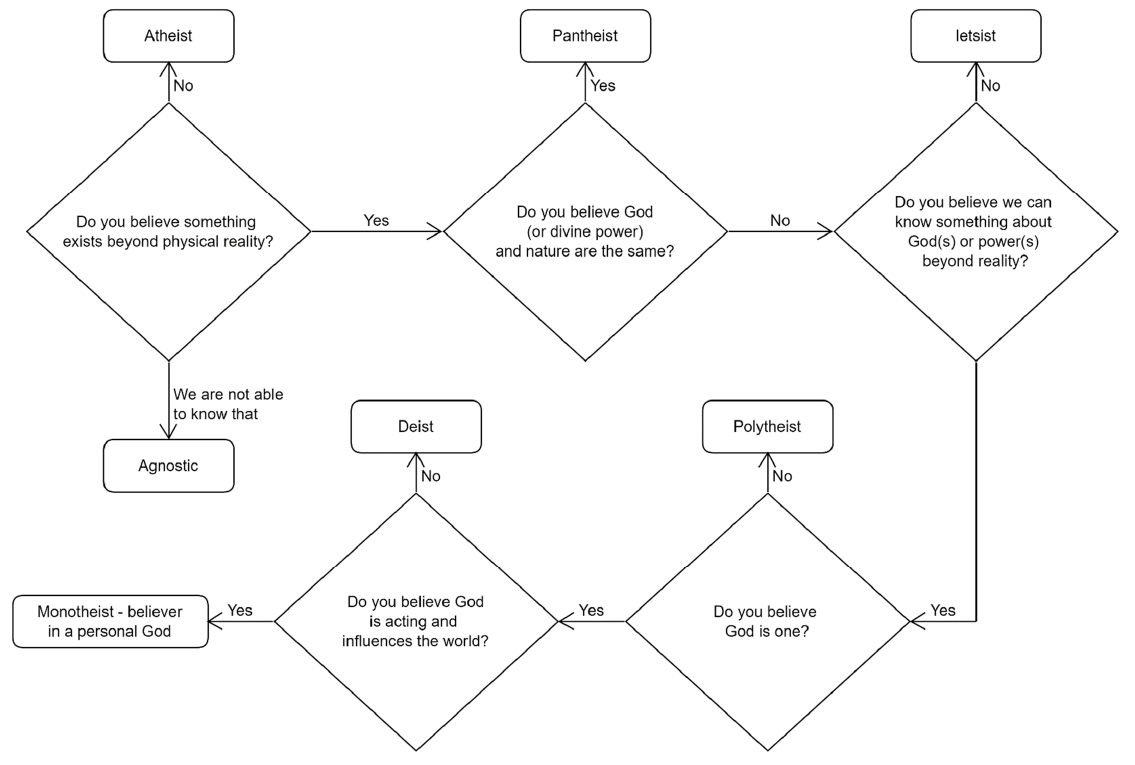
Figure 2. Distinction of religious